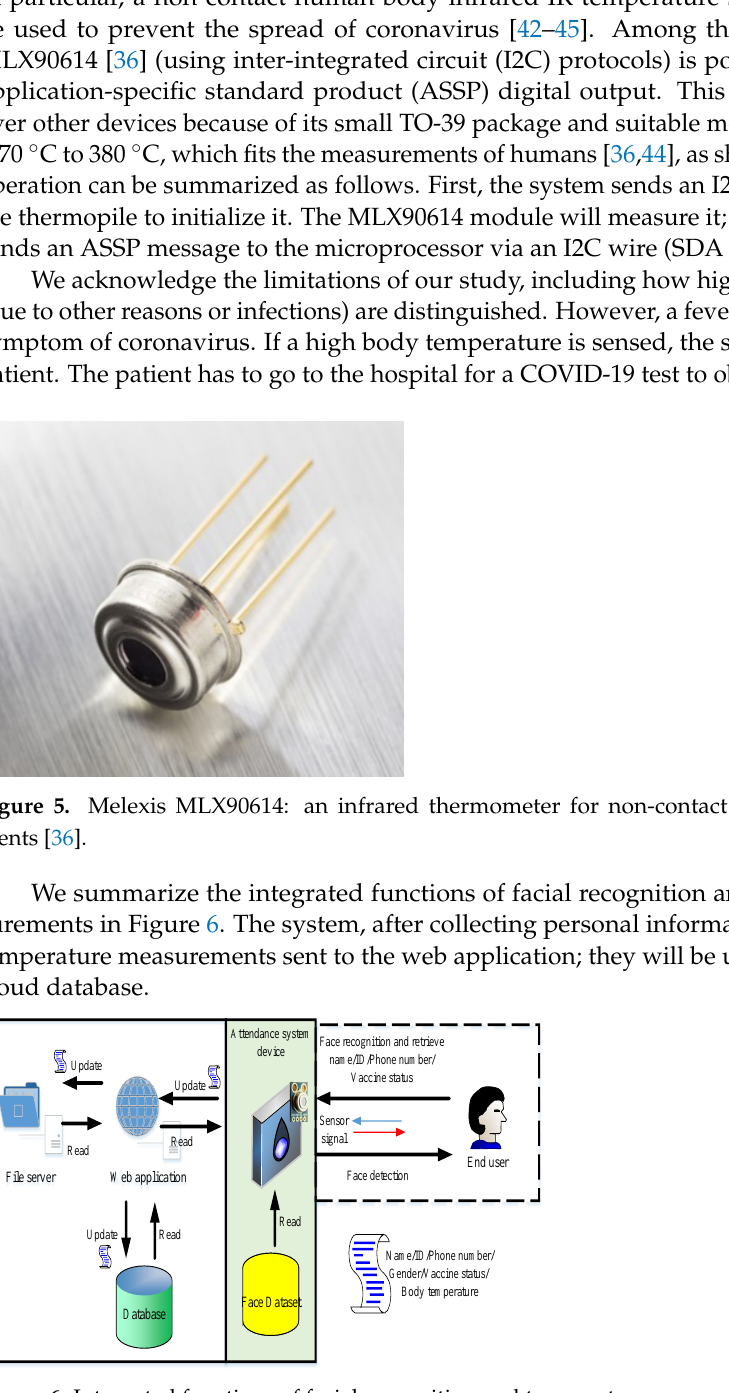
Figure 6. Integrated functions of facial recognition and temperature